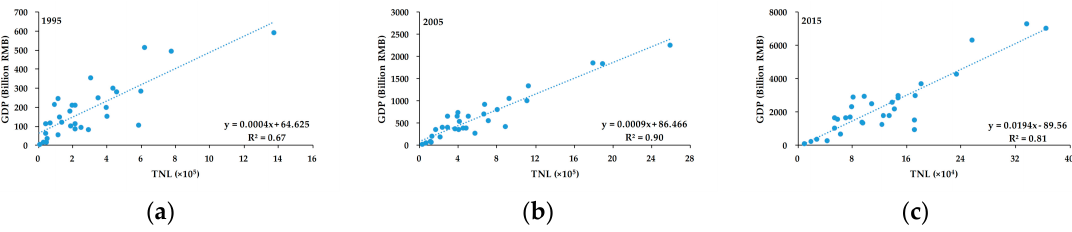
Figure 4. Linear models between the statistical GDP data and TNL in provincial units at the country level: ( a ) the model for 1995 using DMSP-OLS data; ( b ) the model for 2005 using DMSP-OLS data; ( c ) the model for 2015 using NPP-VIIRS data. Table 4. Accuracy assessment of the GDP estimated using a linear model in time series and linear models in provincial units at the country level from 1992 to 2015.